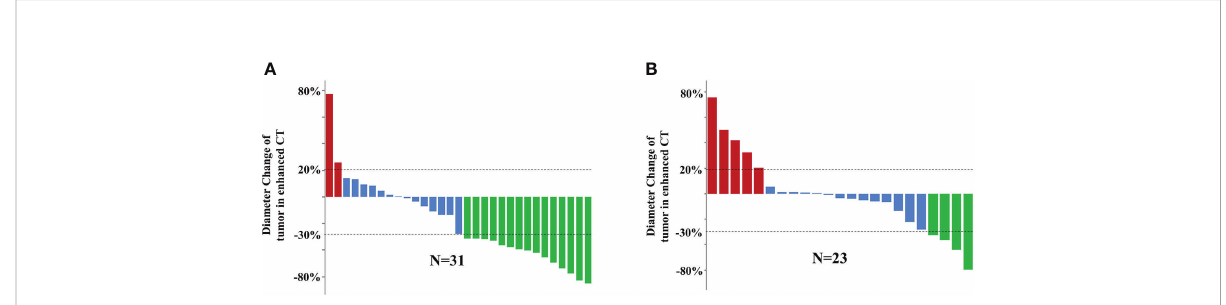
FIGURE 2 Ef fi cacy of 54 HCC patients with two cycles of systemic treatment in the (A) cTACE group and (B) no-cTACE group. Red represents progressive disease, blue represents stable disease, and green represents partial